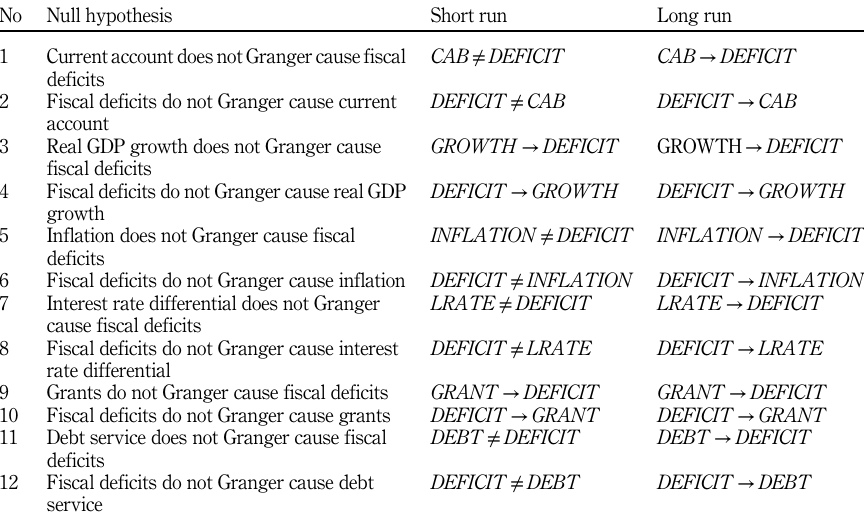
Table 7. Direction of short- and long-run